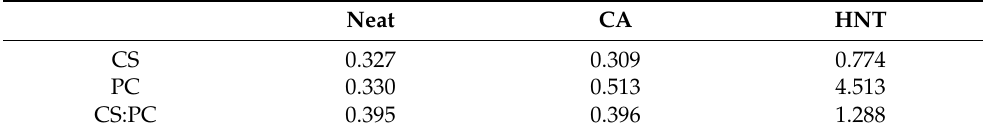
Figure 3. UV–visible spectra of biopolymer films containing citric acid (CA) or halloysite nanotubes (HNT) in which the matrix is ( a ) chitosan, CS, ( b ) pectin, PC, ( c ) chitosan:pectin blend, CS:PC. Table 2. Calculated values of linear attenuation coefficient K 750 (mm −1 ) for all investigated samples.